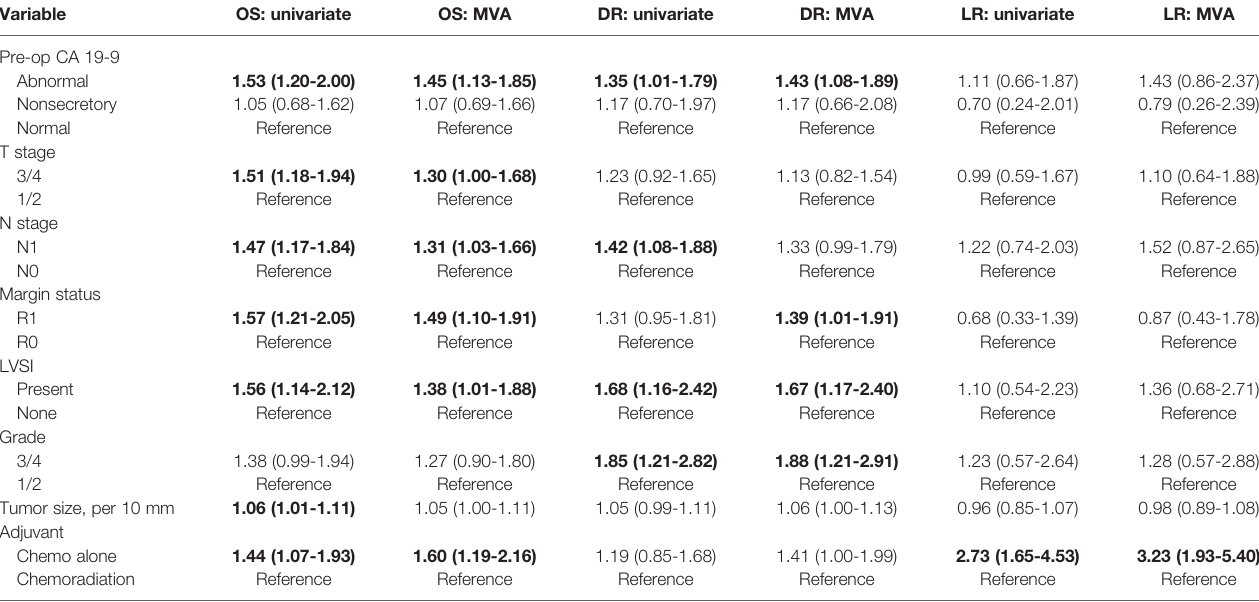
TABLE 3 | Multiple variable (MVA) and univariate Cox analyses for overall survival (OS), freedom from distant recurrence (DR), and loco-regional disease progression (LR) are shown.